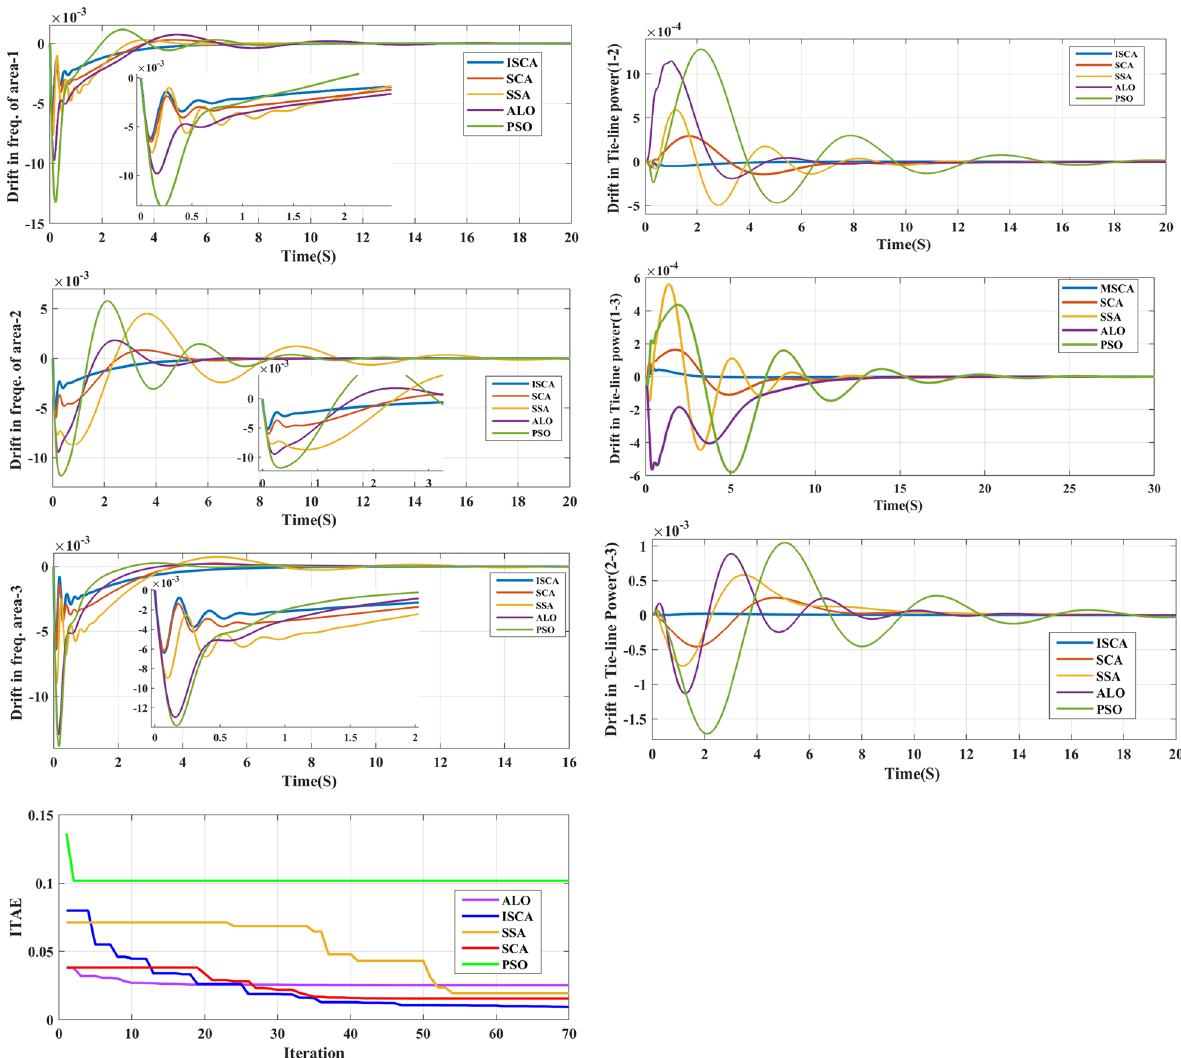
Fig. 6 Transient responses of frequency and tie-line power of all areas and convergence curves of the various algorithms for SLD of 2% in each area with the proposed and other algorithms